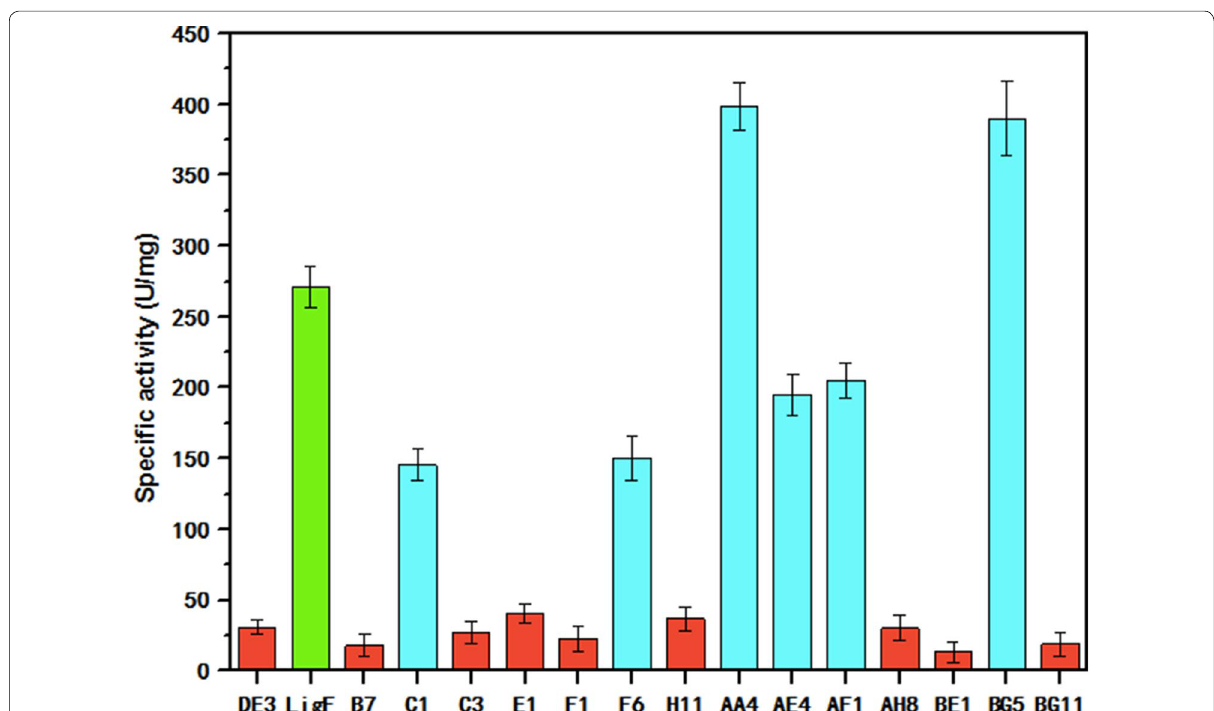
Fig. 5 Enzymatic activity of screened mutants analyzed by HPLC. B7, C1, C3, E1, F1, F6, H11, AA4, AE4, AF1, AH8, BE1, BG5 and BG11 are the mutants described in Table 2. DE3 refers to the cell lysate from BL21(DE3) with pET-23a plasmid. The green column refers to the original LigF. The blue columns refer to the positive mutants with increased activity selected by GSH assay, while the red columns refer to the negative mutants with decreased activity selected by GSH